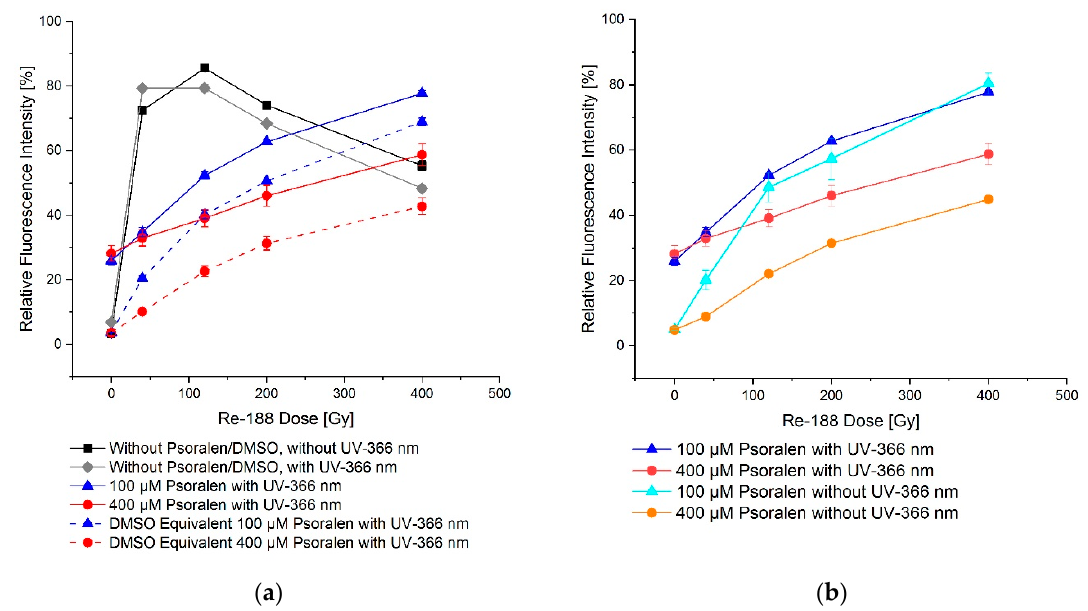
Figure 9. Dose–effect relation on plasmid DNA for Re-188 in combination with psoralen and with ( a )/without ( b ) a 60-min UV-366 nm irradiation. ( a ) shows the additional fluorescence intensity of open circular conformation for mere radiotoxicity with/without UV-366 nm irradiation. There was a difference between the psoralen and the DMSO equivalent effect. In ( b ) the difference of the fluorescence intensity is shown by comparing UV-366 nm irradiation and no irradiation. The effect was larger with UV-366 nm irradiation. The error bars show the SEM.